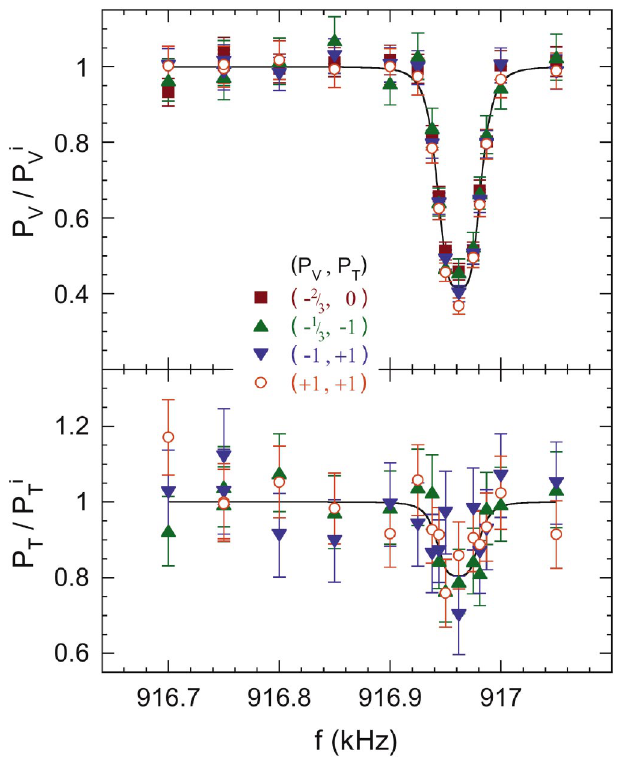
FIG. 3. (Color) The measured vector and tensor deuteron polar- ization ratios at 1850 MeV =c are plotted against the rf dipole’s and P i are the average of the six points fixed frequency. The P i V T dl furthest from the deep for each curve. The rf dipole’s R B rms was 0 : 54 T mm . The curves are second-order Lorentzian